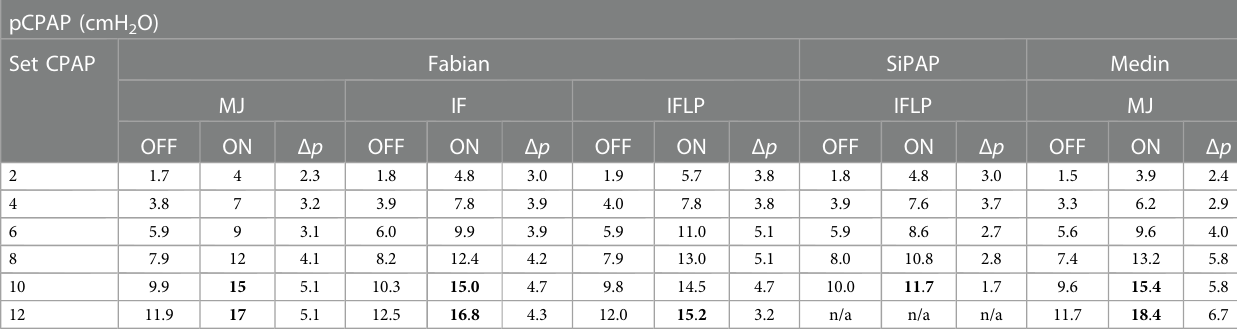
TABLE 2 Comparison of pCPAP values measured in Fabian, SiPAP and Medin CPAP ventilator (with different interfaces) without the O 2 -FS (OFF) and with the O 2 -FS (ON). pCPAP (cmH O) 2 Set CPAP Fabian